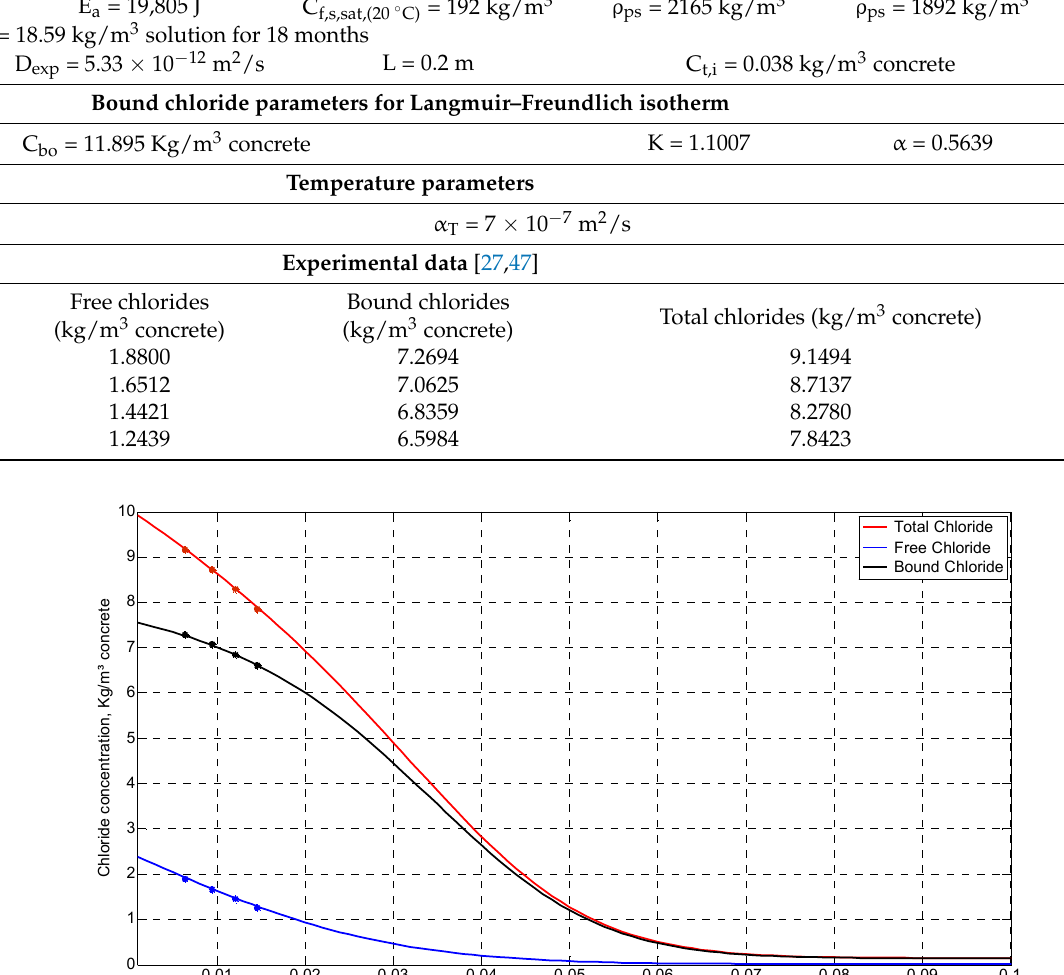
Figure 16. Experimental and Concrelife concentration profiles.